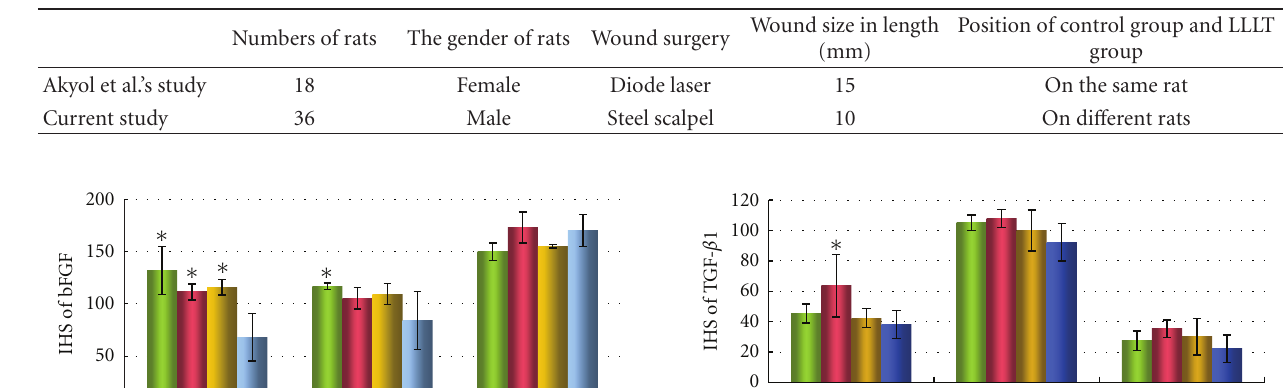
Table 2: The di ff erences of the animal models in two studies.